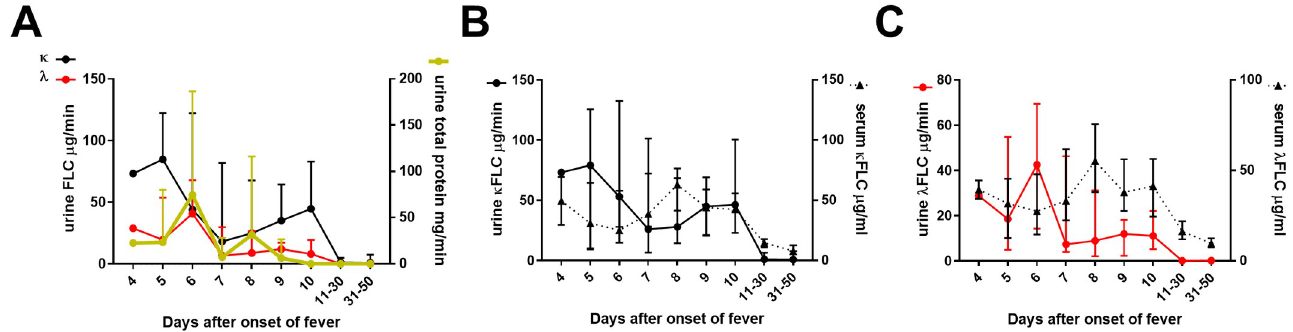
Fig 3. FLCs increase in urine in patients with acute PUUV-HFRS. ( A ) The concentration of FLCs and total protein levels were measured in sequential urine samples from the same patients as in Fig 2A and 2B. The protein concentrations in urine was normalized based on total urinary volume produced during an overnight ~8h collection. The kinetics of κ FLC (in B) and λ FLC (in C ) secretion in urine and in circulation (serum samples, same data as in Fig 2A) were compared. The medians ± interquartile ranges are shown.